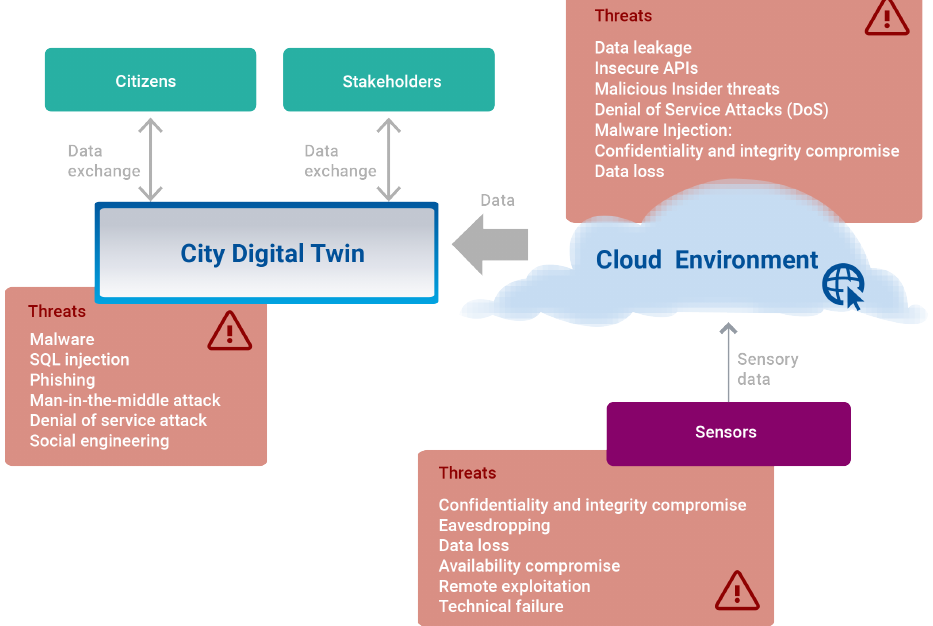
Figure 5. View of the possible cyber security threats in the context of city digital